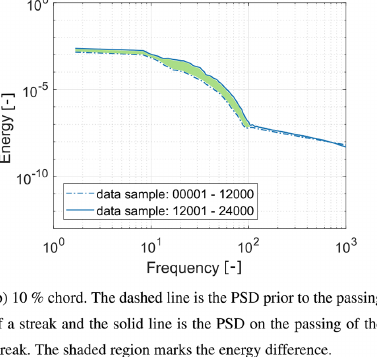
Figure 12. Influence of a boundary layer u (cid:48) streak on the PSD plot at TI = 5.6%.